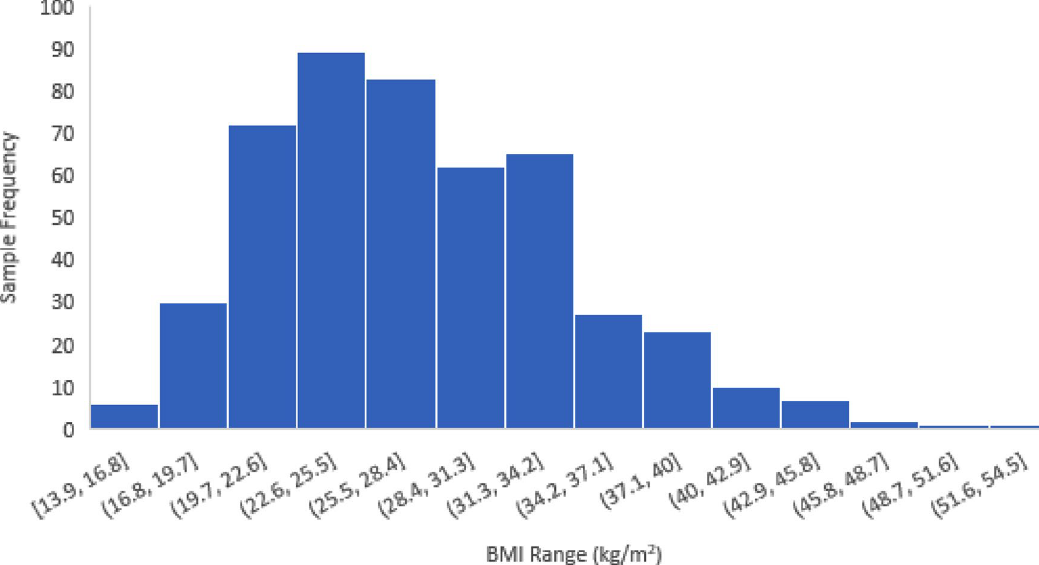
Figure 4. Histogram of most recent BMI measurement, n = 478. Five of the 483 adults in the sample did not have a body mass index (BMI) measurement from the past 5